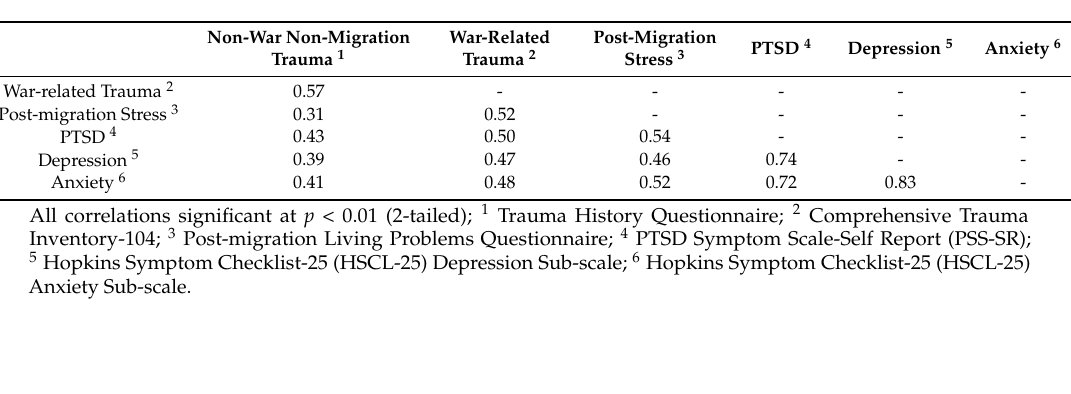
Table 2. Correlations among Stress Constructs and Mental Health